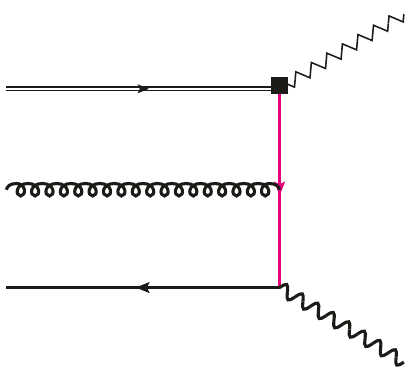
Figure 3 . Diagrammatical representation of the three-particle contributions to the vacuum-to- B - meson correlation function (cid:5) (cid:22) ( n (cid:1) p; (cid:22) n (cid:1) p ) de(cid:12)ned in (2.1) at tree